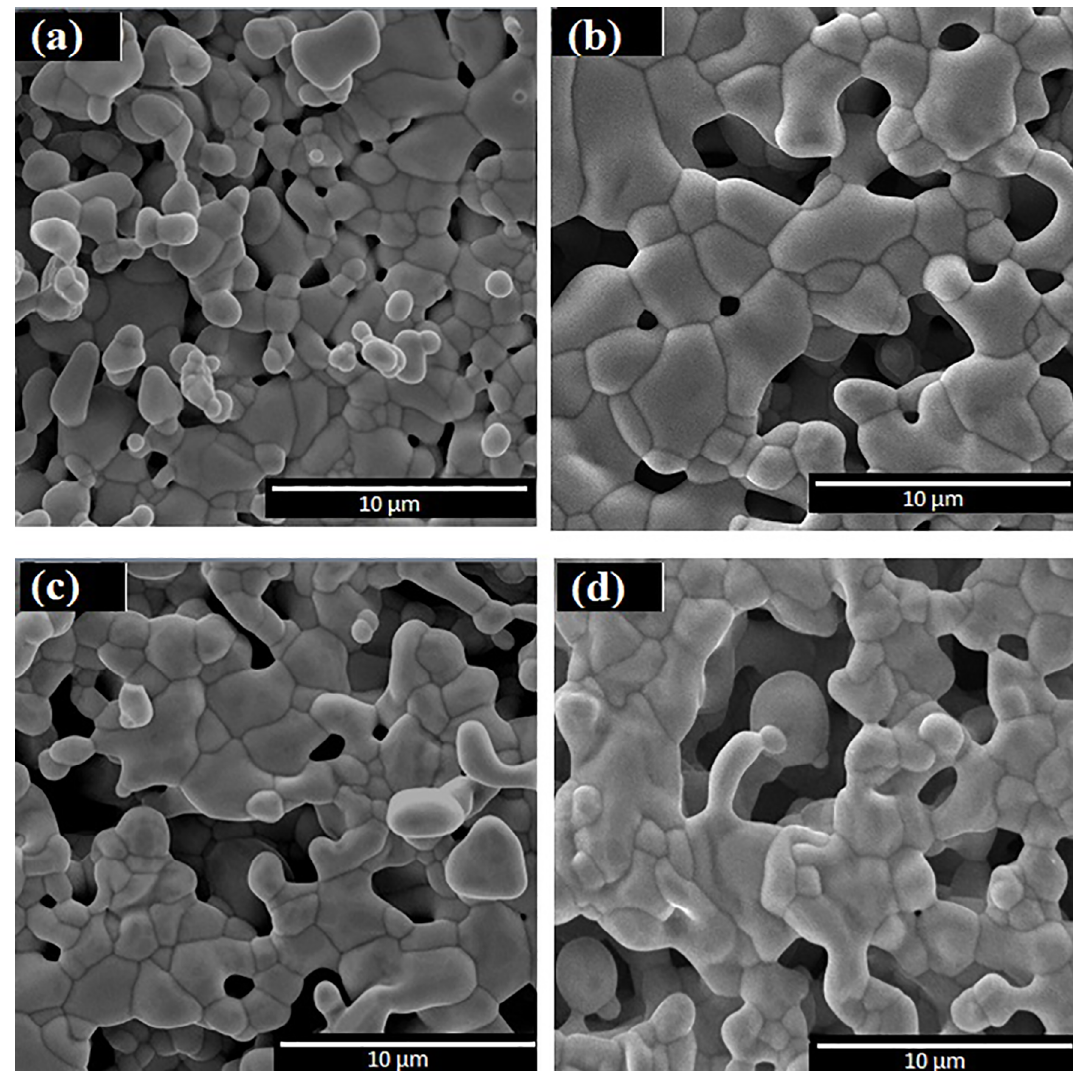
REE Fe O (REE = Gd, Dy and Lu) with x = 0.0 and 3−x x 5 12